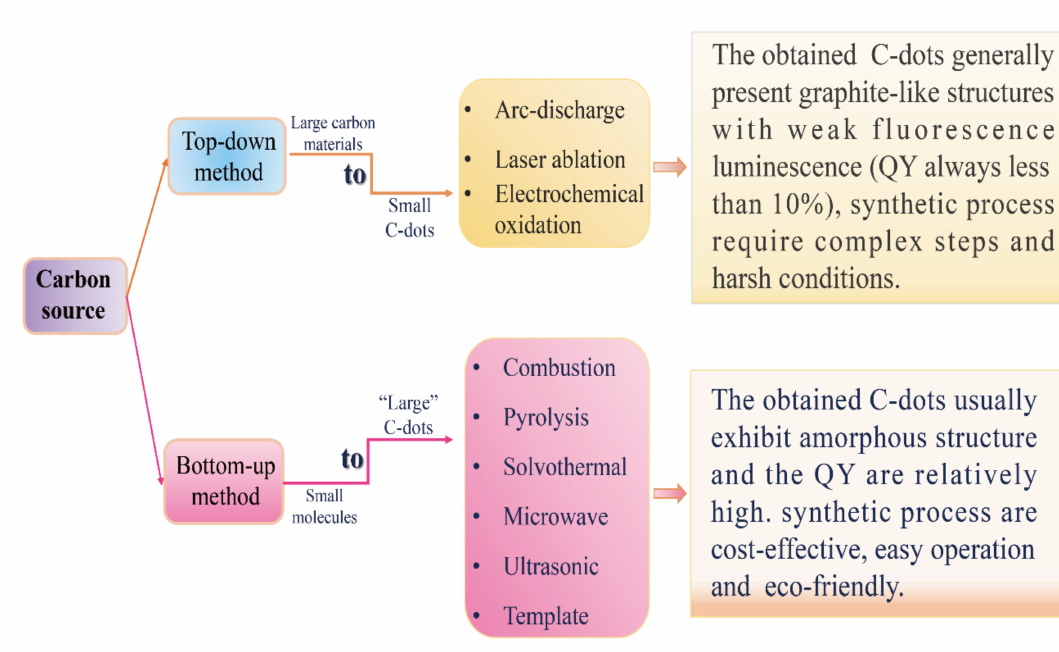
Figure 1. The top-down and bottom-up approaches for synthesizing of C-dots (QY refers to fluorescence quantum